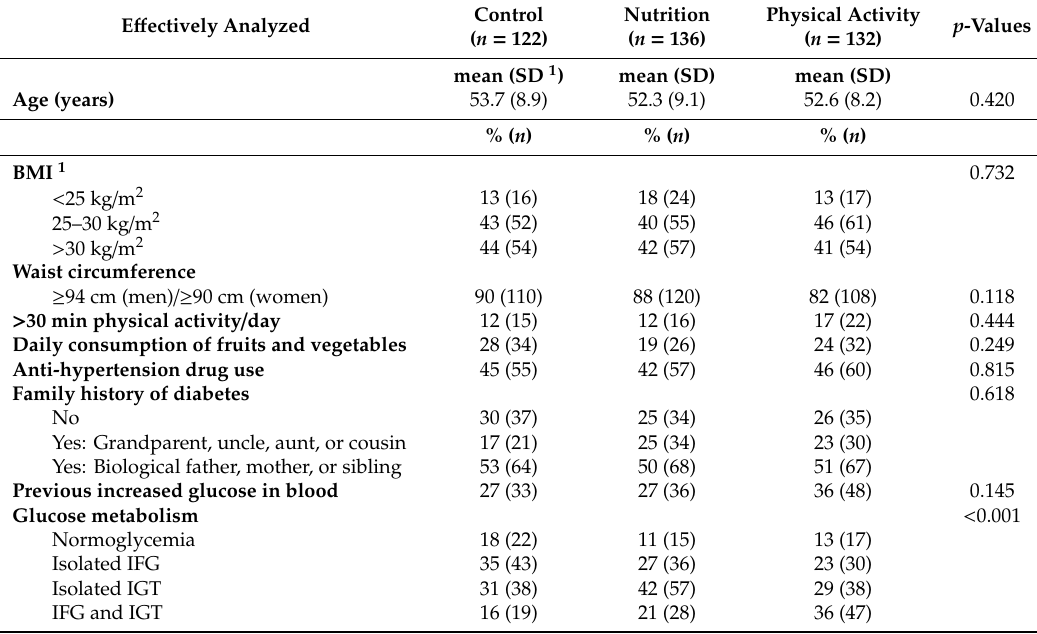
Table 2. Baseline characteristics of the study participants included in the analysis.